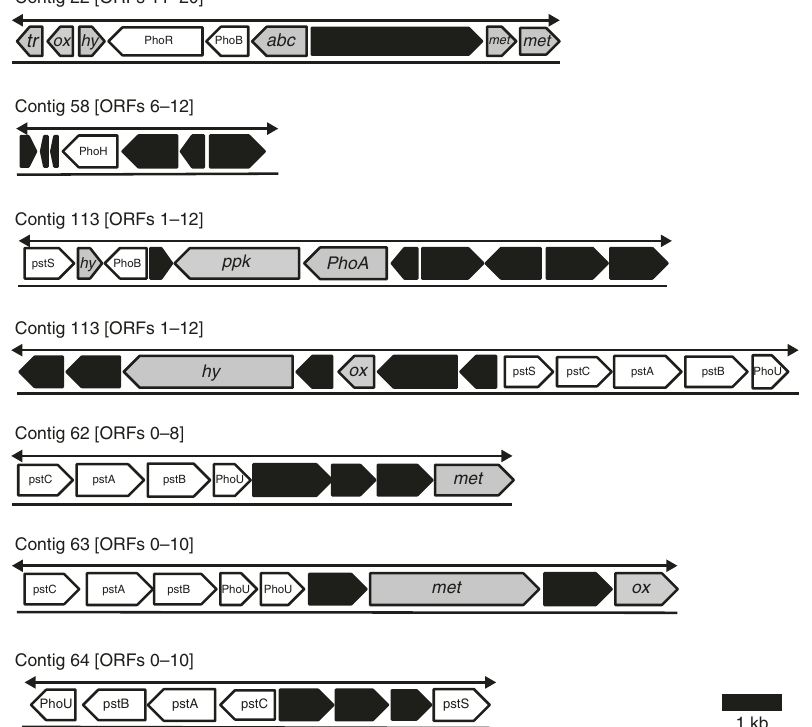
Fig. 2 Phosphorus gene positions in the genome of Chlorobium phaeoferrooxidans strain KB01. Highlighted are the positions of genes involved in high-af fi nity inorganic phosphorus (P i ) uptake (white), including components of the pho regulon, alkaline phosphatase ( PhoA ), and polyphosphate kinase ( ppk ). Also shown are positions of transcriptional regulator and transposase proteins ( tr ), membrane, envelope, and transporter proteins ( met ), hydrolases ( hy ), oxidoreductases ( ox ), ABC transporter proteins ( abc ), and other proteins (black) in each open-reading frame (ORF). kb